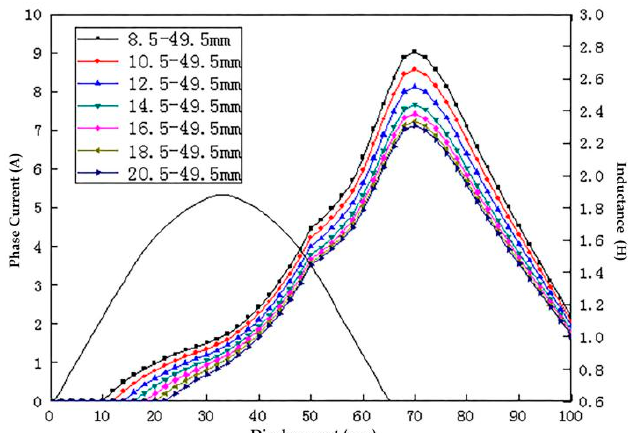
Figure 8. The turn-off positions are all 49.5 mm. The phase current waveforms at different turn-on positions are shown in Figure 8, it can be seen from the Figure 8 that the phase current is greatly affected by the opening position.